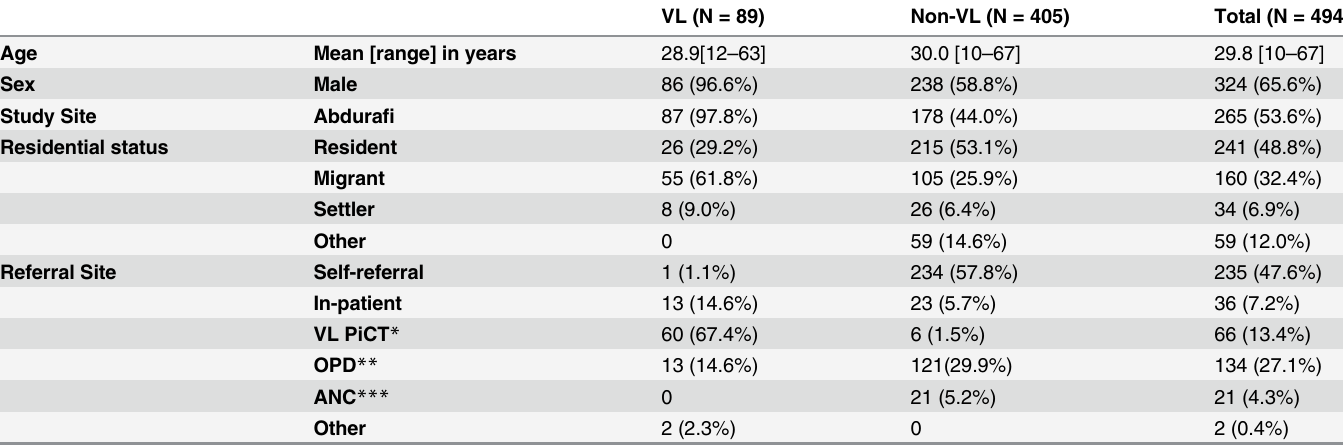
Table 1. Demographics of study participants by visceral leishmaniasis (VL) status.